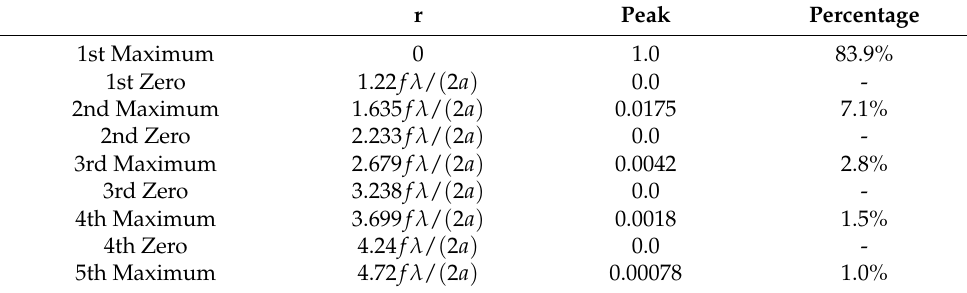
Table 1. Intensity distribution of each ring of the diffraction